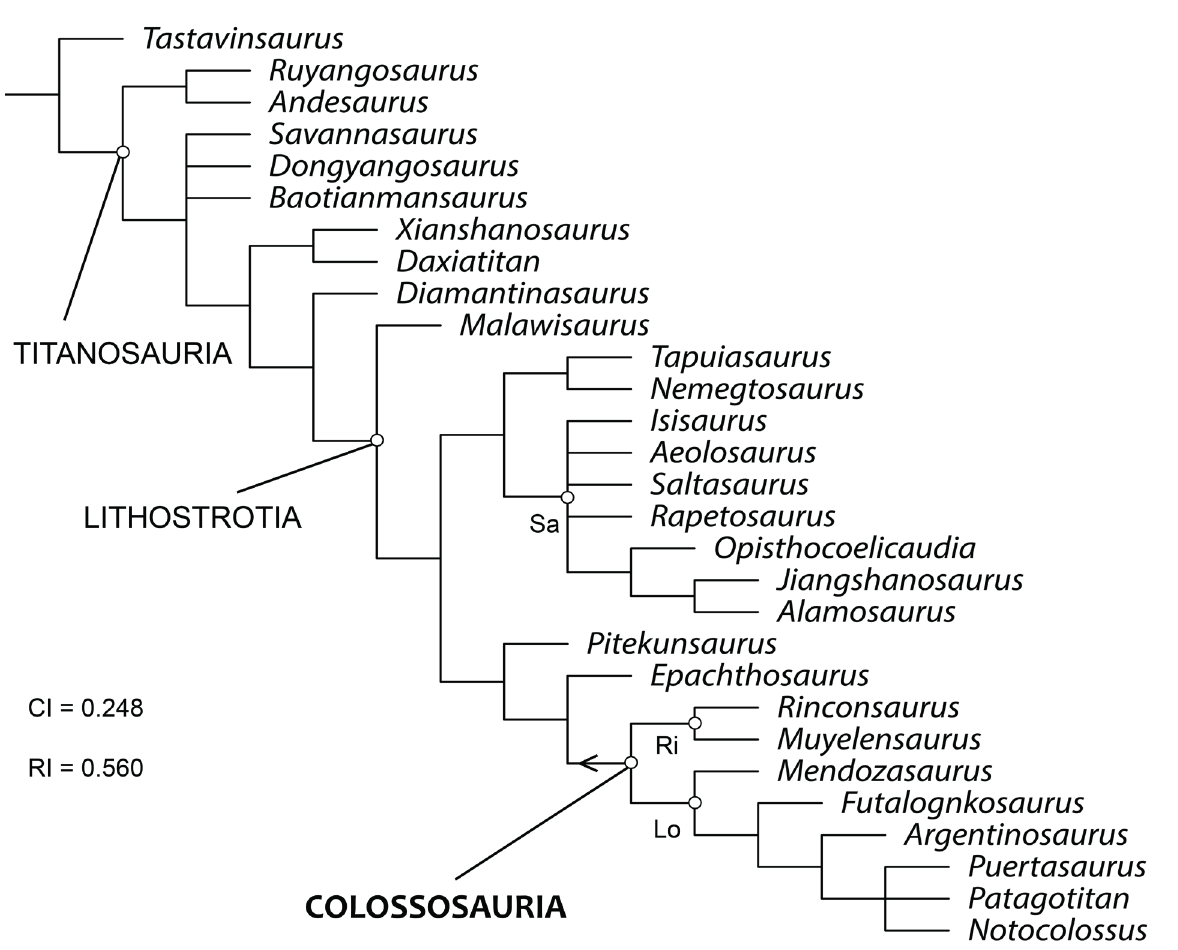
Figure 11 – Strict consensus cladogram (limited to titanosauria) generated from a revised analysis of the data matrix of González riga et al. (2018) with the addition of three characters (this paper), showing the position and taxonomic content of the newly- recognized stem-based clade Colossosauria. Abbreviations: Lo, Lognkosauria, ri, rinconsauria, Sa,